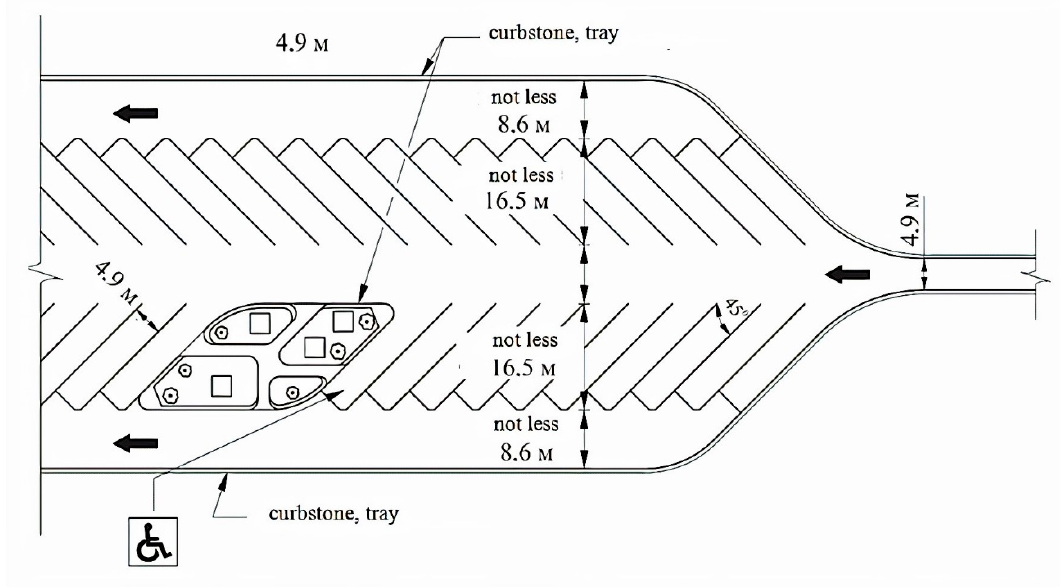
Figure 3. Scheme of parking spaces for trucks in the USA.